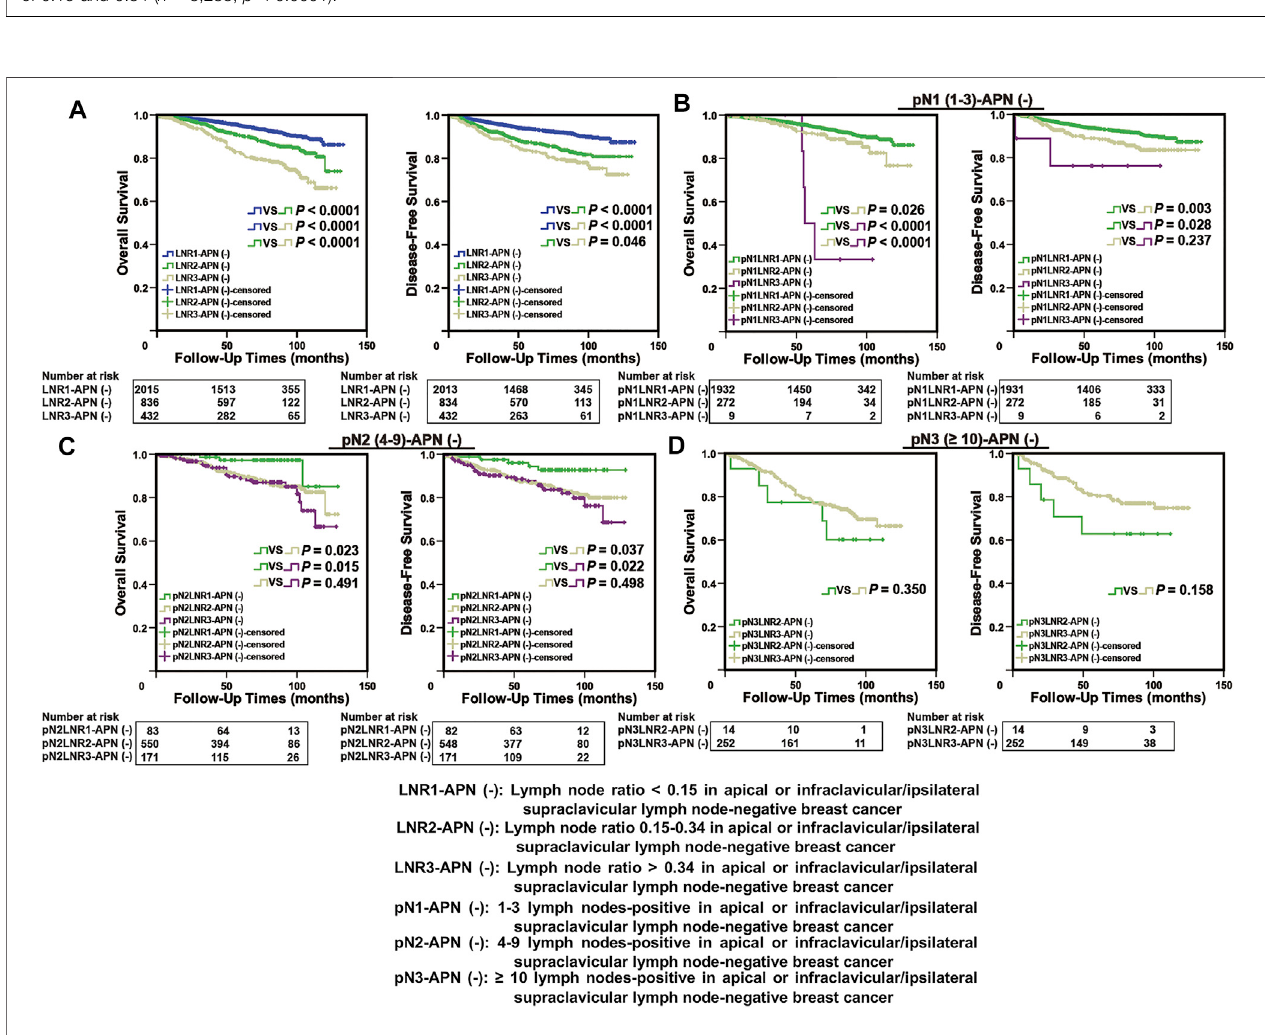
FIGURE4| LNR-APN( − )couldaccuratelypredicttheprognosisofAPN( − )breastcancerpatients.Kaplan – Meieranalysisof (A) LNR-APN( − )breastcancerpatients ( n = 3,283), (B) pN1-LNR-APN( − ) breast cancer patients ( n = 2,213), (C) pN2-LNR-APN( − ) breast cancer patients ( n = 804), and (D) pN3-LNR-APN( − ) breast cancer patients ( n =